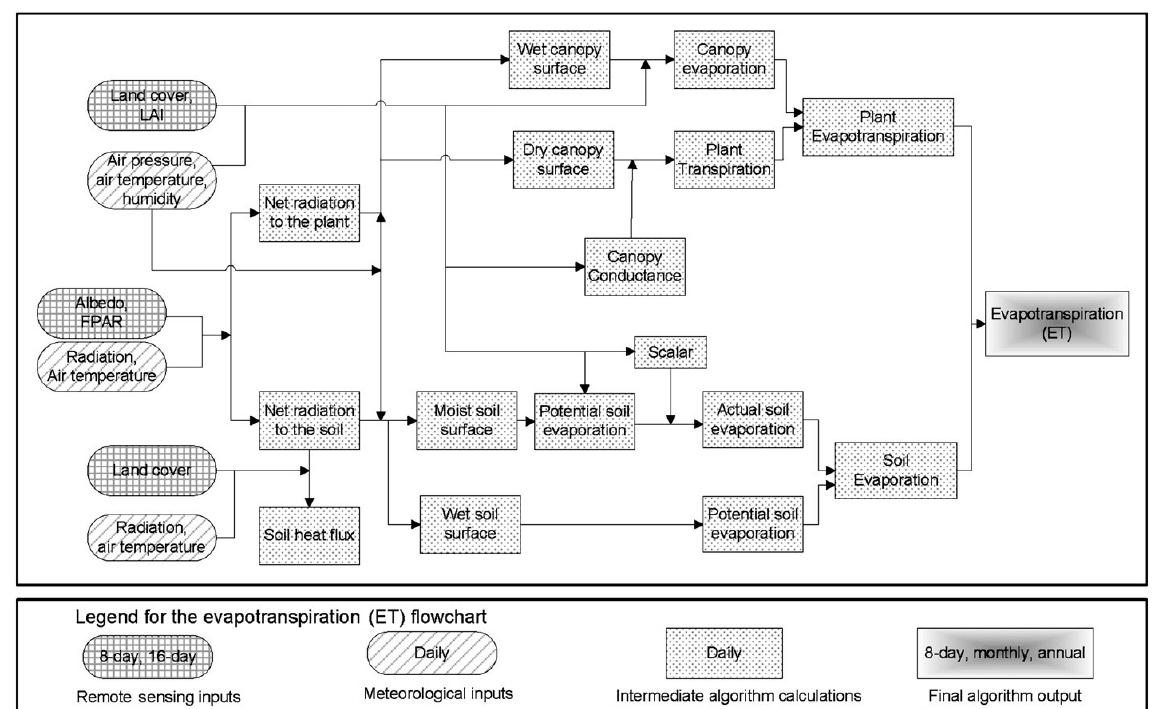
Figure 2. Flowchart of the MOD16 ET algorithm (Mu et al.,